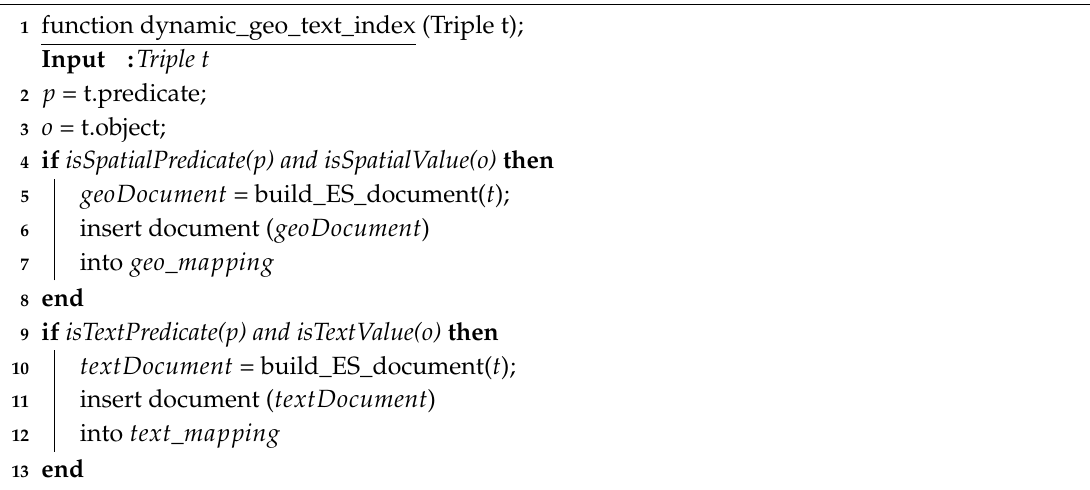
Algorithm 2: A procedure that will read a streaming triple and index its spatial and text data in ElasticSearch.